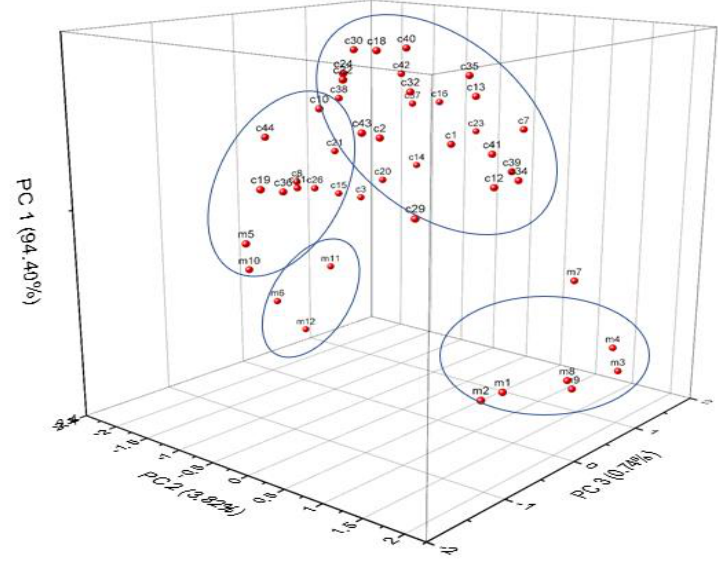
Figure 6. PCA of the bricks (c) and mortars (m).